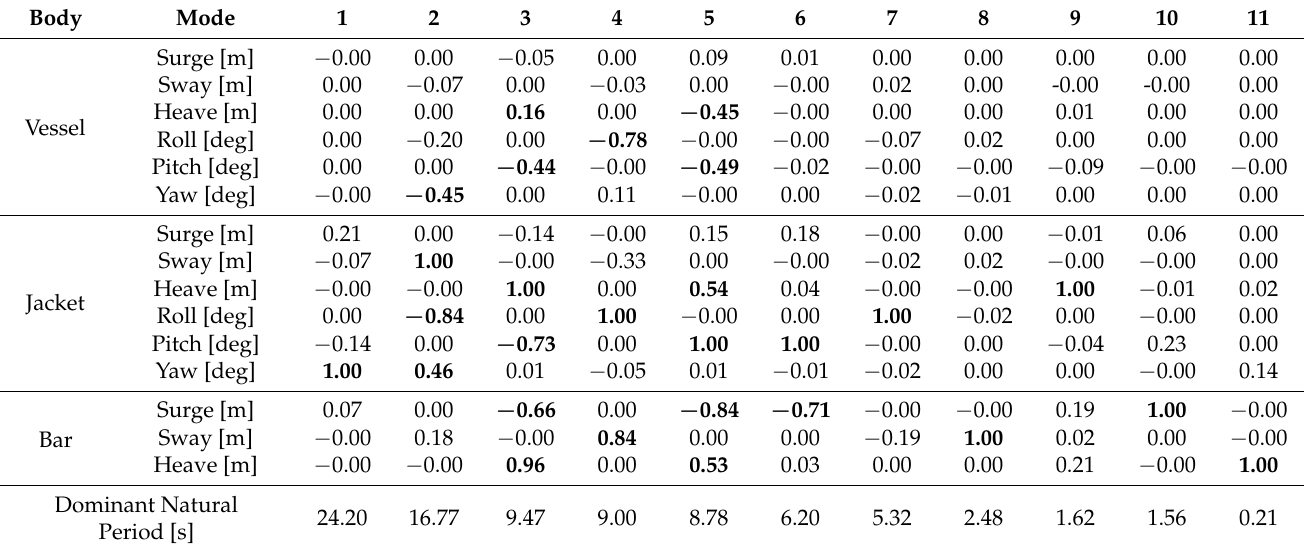
Table 9. Eigenvalues and natural periods of rigid body motions of fully coupled lowering